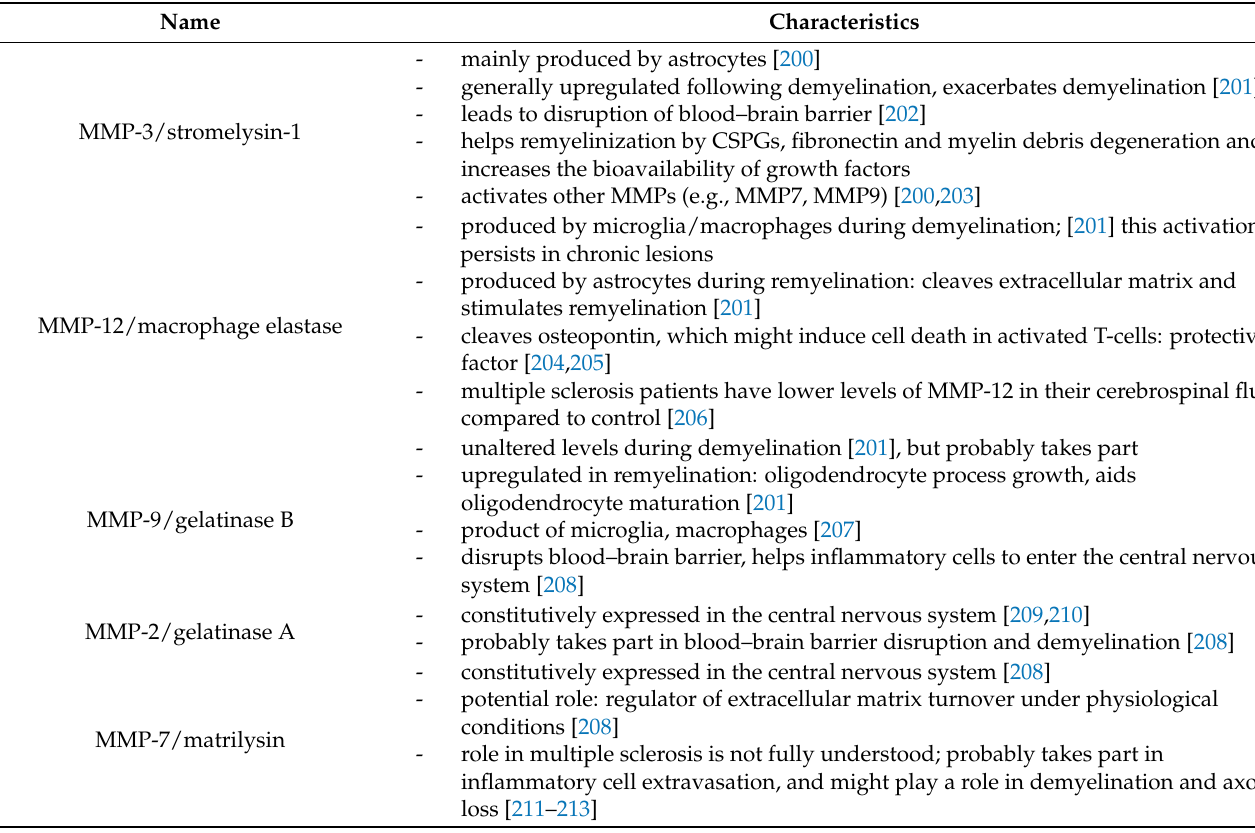
Table 1. Actions and characteristics of